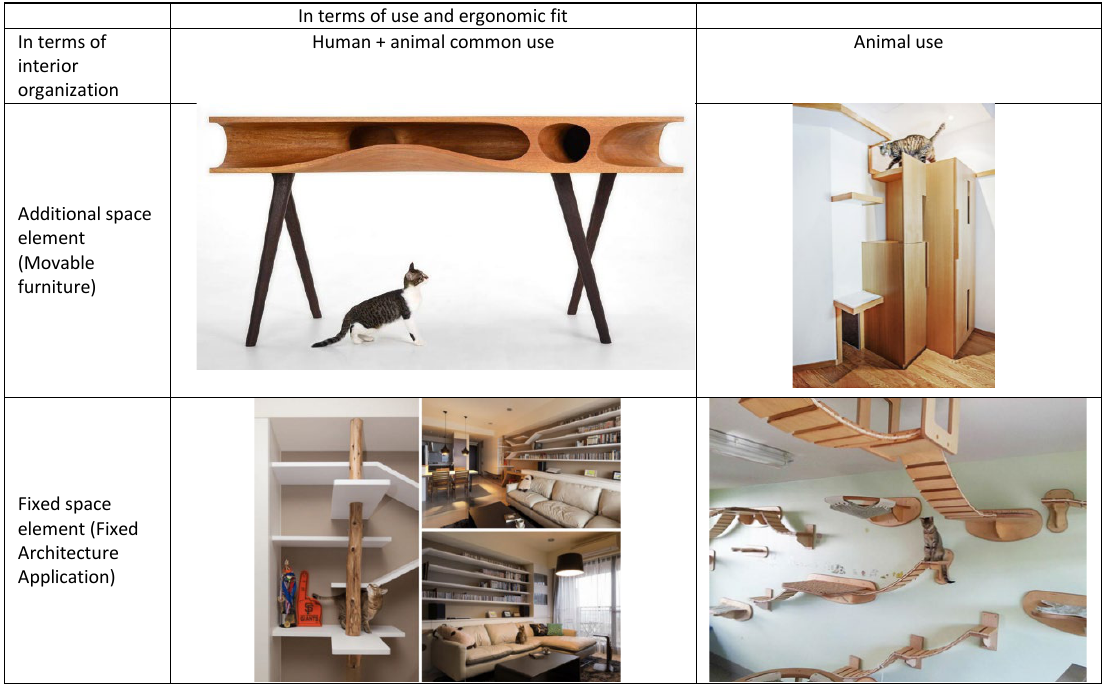
Table 1 Human-animal use, space-item relationship (created by